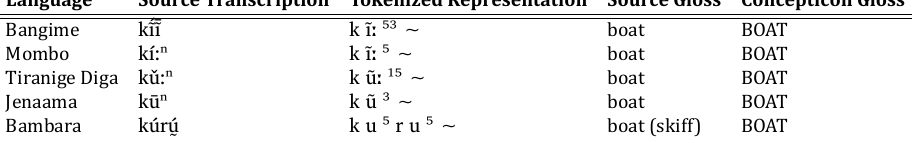
Table 2: Illustration of data conversion in our